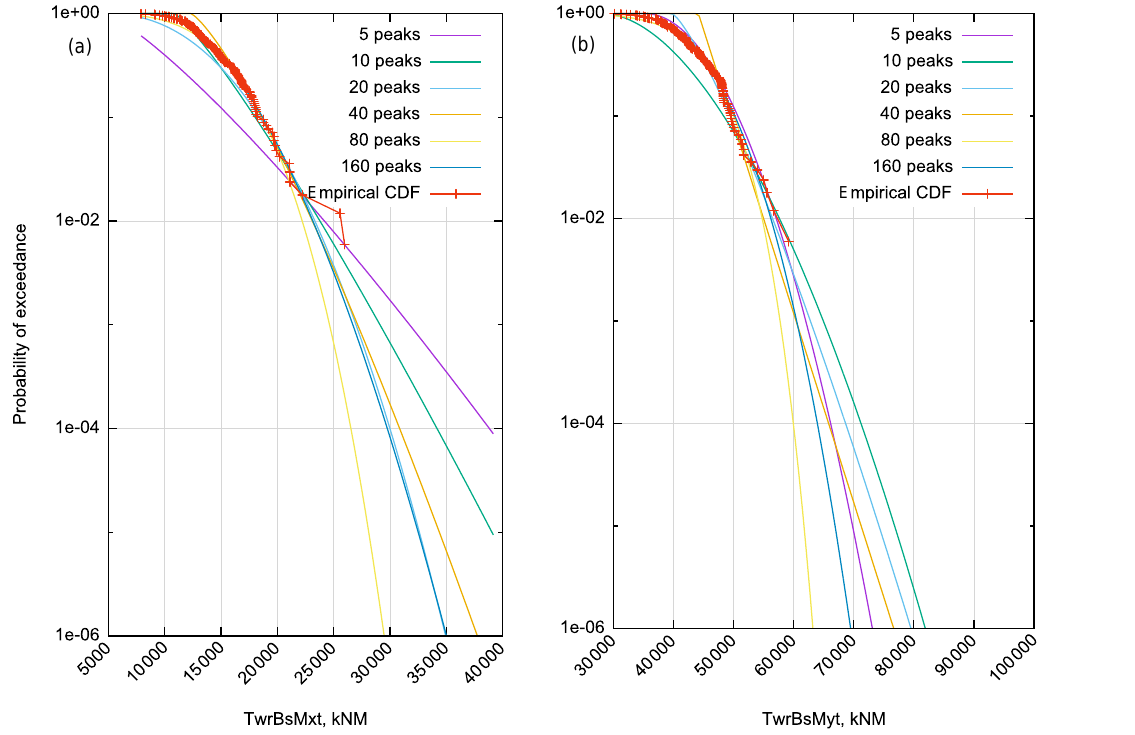
Figure 2. Weibull three-parameter fits to the empirical CDF for the wind speed bin centered at 20ms − 1 for a variety of choices for how many peaks M pks we use for the fit for side–side (a) and fore–aft (b) tower base loads. In all cases we are fitting the analytical CDF to the highest M pks loads of the empirical CDF (a lower value of M pks is like a higher threshold in the peak-over-threshold method). Especially for the side–side moment, the extrapolated POE values depend heavily on how many peaks are